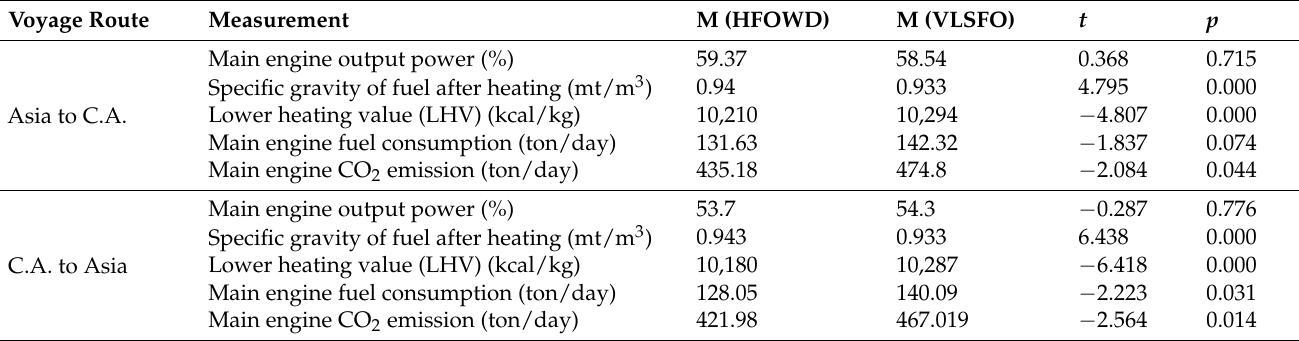
Table 3. Comparison of the parameters for HFOWD and